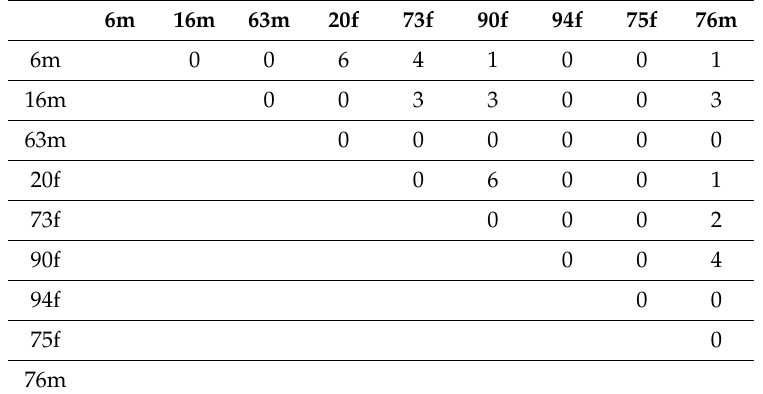
Table 2. Grooming matrix (mean = 0.944; SD = 0.472).